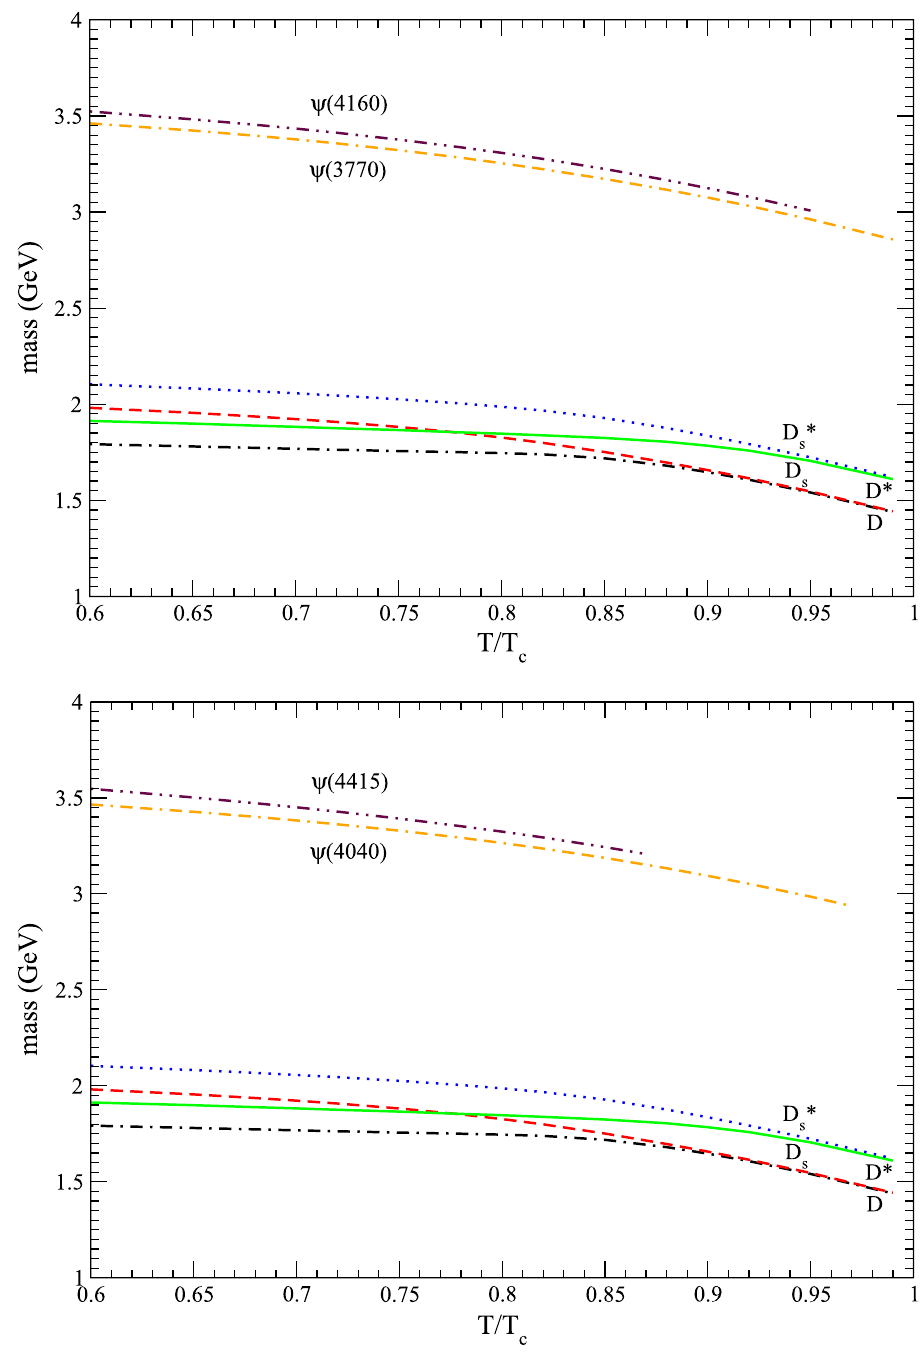
Fig. 4 D , D ∗ , D s , D ∗ s , ψ( 3770 ) , and ψ( 4160 ) masses as functions of T / T c